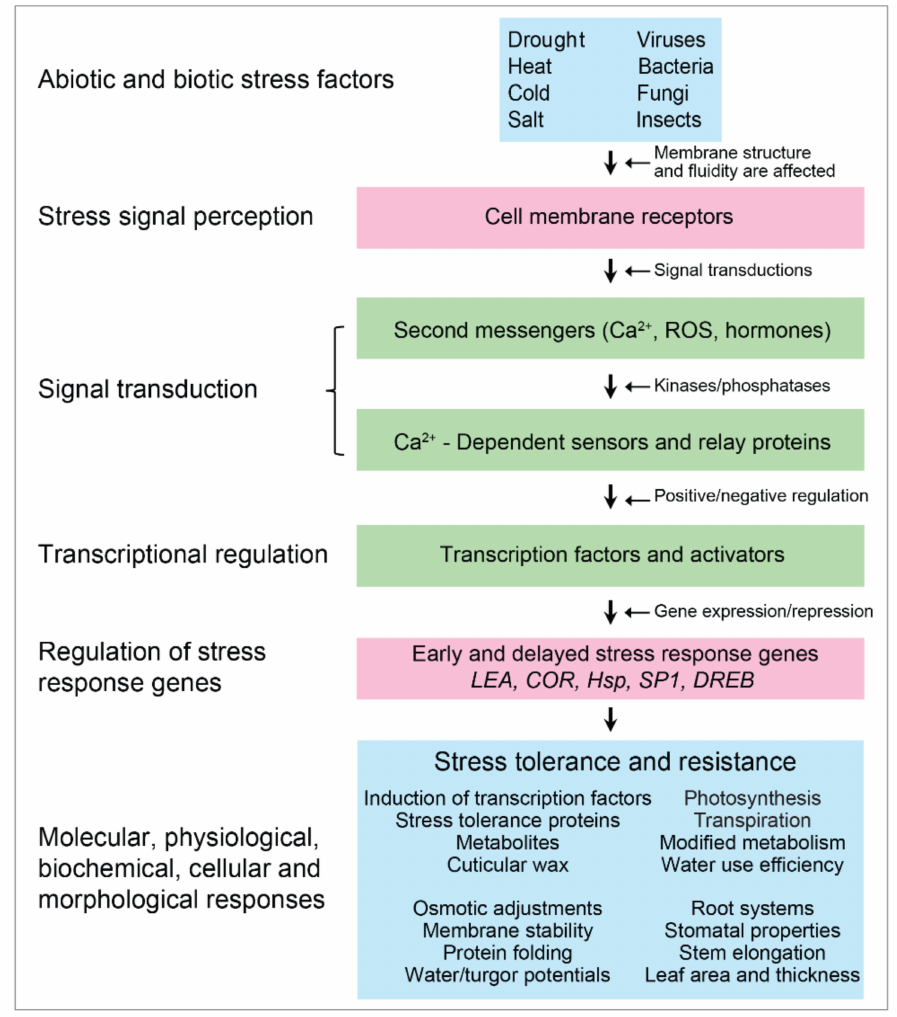
Figure 1. Plants respond to abiotic and biotic stresses through signal transduction pathways. An extracellular signal is perceived via receptors localized in membranes that lead to the activation of signal transduction pathways. The signal cascade (through second messengers, sensors, and kinases that activate a variety of TFs) results in the expression of multiple stress-responsive genes, which mediate stress tolerance and resistance, and restore the cellular and tissue homeostasis [6,18,25]. After plants are exposed to stress, the stress signal is received on the cell surface recep- tor, whereby signal transduction occurs through the accumulation or release of Ca 2+ ions, and/or through the de novo synthesis of the second messenger molecules such as reactive oxygen species (ROS), inositol trisphosphates, hexaphosphate, and diacylglycerols [47]. These second messengers start regulating intracellular concentrations of cytosolic Ca 2+ ion levels that lead to the biosynthesis of Ca 2+ ion-binding proteins which activate calcium- dependent protein kinases (CDPKs) [48] and other relay proteins [44]. In turn, activated kinases and phosphatases initiate phosphorylation/de-phosphorylation of specific TFs, leading to the expression of stress-responsive genes [6]. As a result, switching on a series of phosphorylation/de-phosphorylation cascades via presumable kinase and phosphatase enzymes leads to stress tolerance. During this stress tolerance phase, the expression of functional genes involved in cellular protection in vegetative tissues results in the accumu- lation of various stress resistance proteins and molecules (Figure 1), and as a result, plants surpass unfavourable conditions